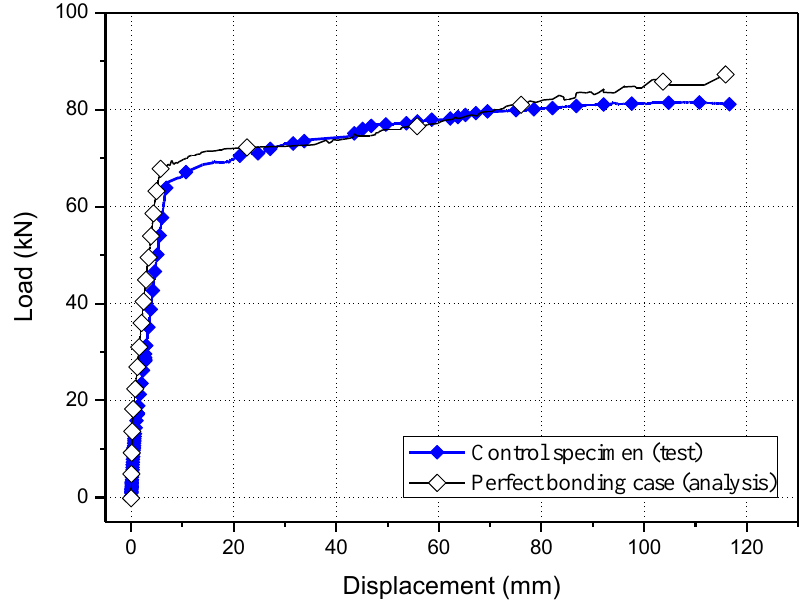
Figure 13. Comparison between test and analysis results of flexural beam specimen.